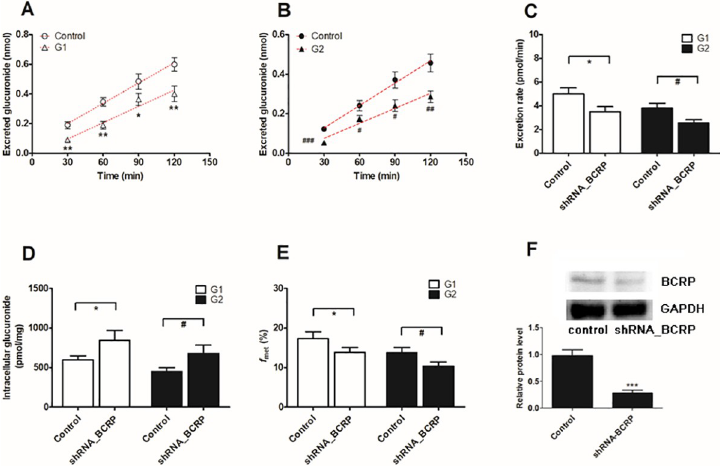
Fig 8. Effects of BCRP silencing on excretion rates and intracellular levels of demethoxycurcumin- O -glucuronides in HeLa1A1 cells. (A) Effects of excreted demethoxycurcumin- O -glucuronides (G1) in extracellular medium; (B) Effects of excreted demethoxycurcumin- O -glucuronides (G2) in extracellular medium; (C) Effects of the efflux excretion rates of G1 and G2; (D) Effects of the intracellular G1 and G2 levels; (E) Effects of the fraction metabolized ( f met ) of demethoxycurcumin; (F) Effects of gene silencing on the protein level of BCRP. The concentration of demethoxycurcumin was 4 μ M. All experiments were performed in triplicate (n = 3). Data were presented as mean ± SD (n = 3). � , # p < 0.05, �� , ## p < 0.01 and ��� , ### p < 0.001 compared with that of control group of G1 or G2, respectively.